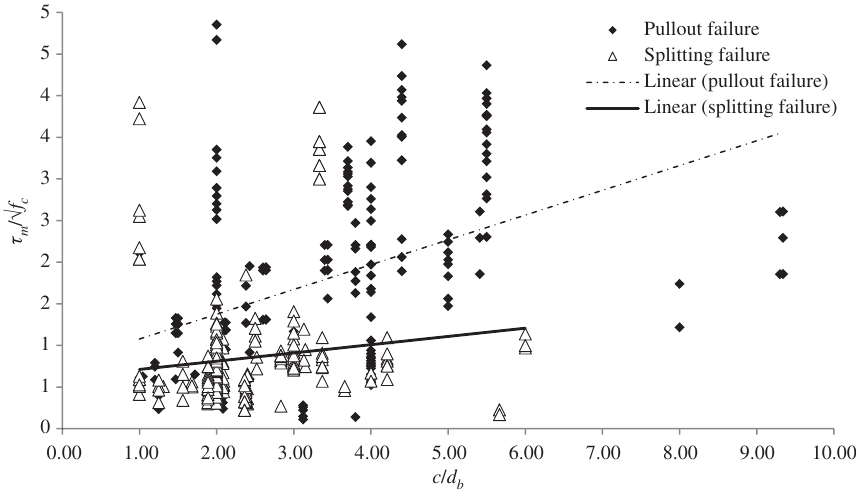
Figure 7: Normalised average bond strength with concrete cover-to-bar-diameter